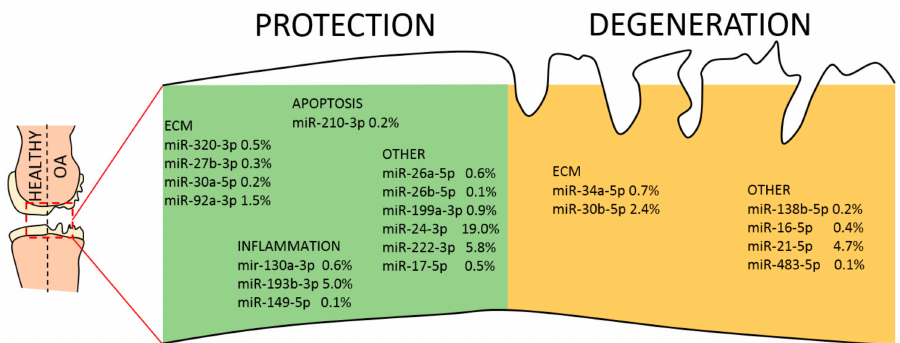
Figure 7. EV-miRNAs involved in protective or destructive mechanisms in the OA joint. Indication of miRNAs in the first quartile of expression in ASC-EVs and their role in cartilage homeostasis. miRNAs are divided per category and the relative amount of their genetic message